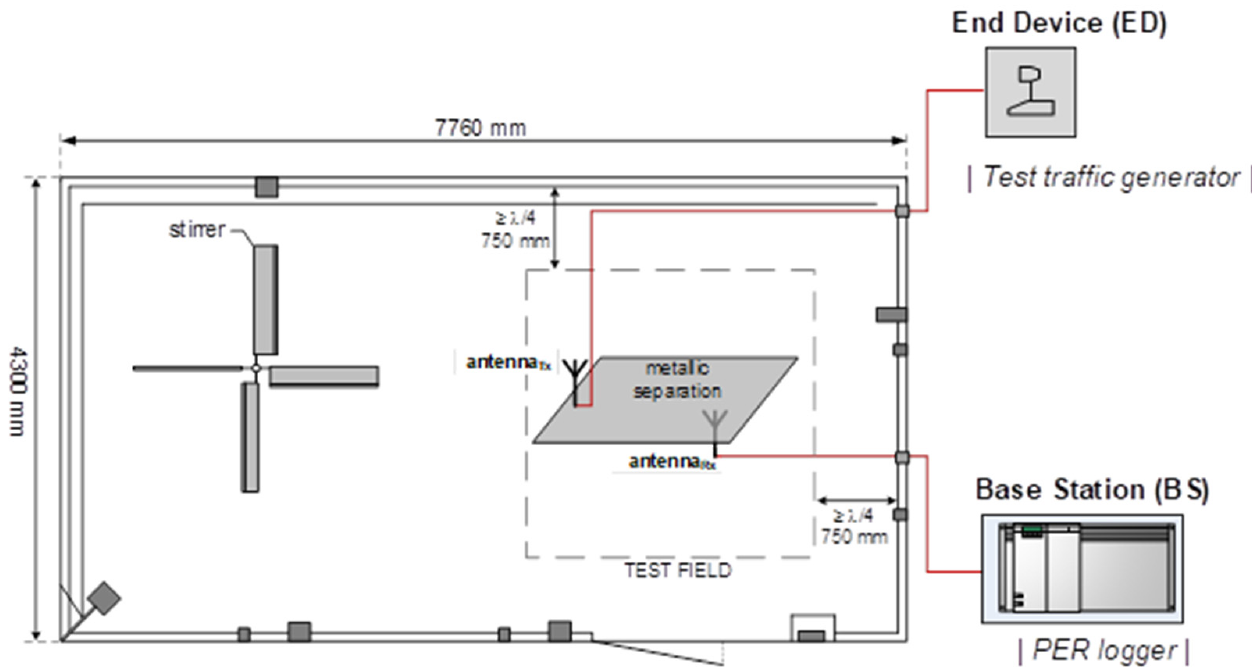
Figure 9. A schematic of the set-up used for measuring the Wireless M-Bus system in the LKE (WUST) reverberation chamber.